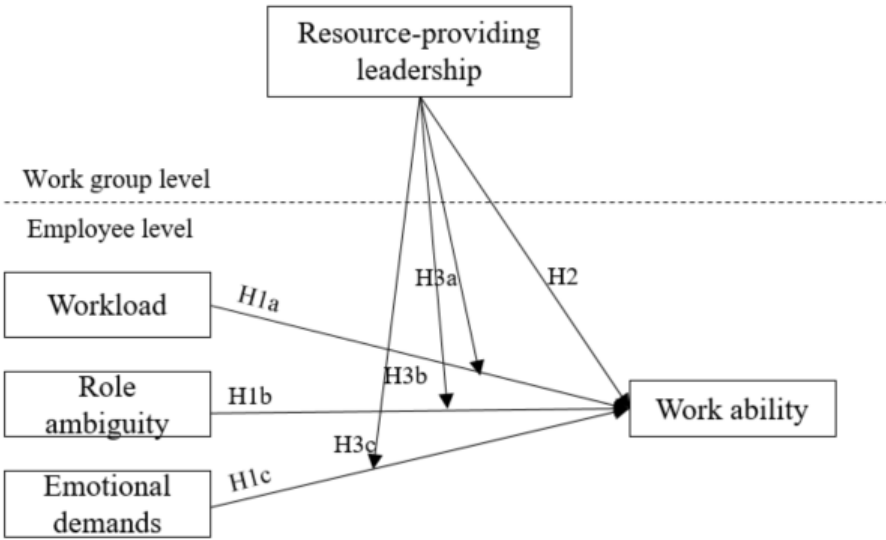
Figure 1. The conceptual model of employee-level job demands and work group-level resource- providing leadership predicting work